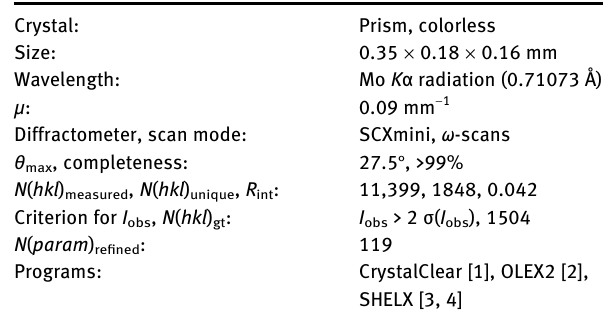
Table 1 contains crystallographic data and Table 2 contains the list of the atoms including atomic coordinates and displacement parameters.